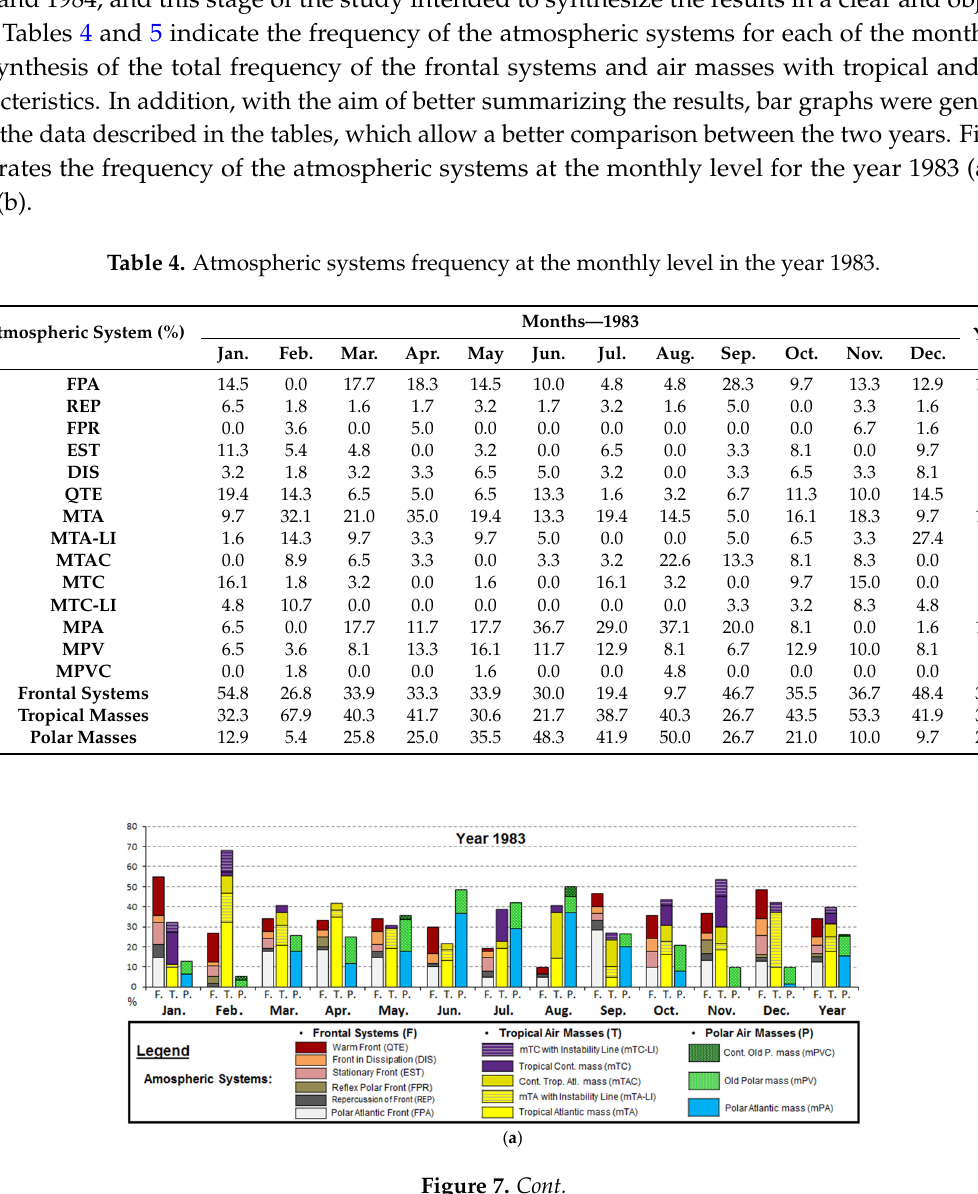
22.0 The results observed in the tables indicate a high frequency of occurrence of frontal systems and other disturbing influences in the south of Brazil in the year 1983, as compared to 1984. These results reinforce the idea that the performance of the polar front and its unfolding are the main factors that are responsible for the occurrence of intense rainfall in the state of São Paulo, as [69,70] suggests, and the observation of which will be discussed later in the paper. Another point that draws attention is